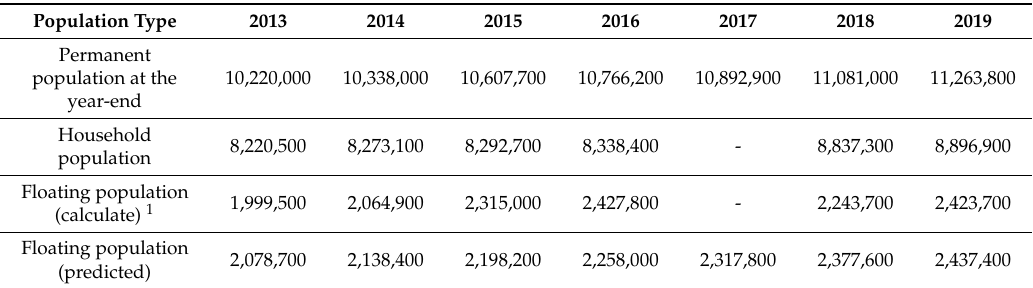
Table 3. Prediction of floating population living in Wuhan,